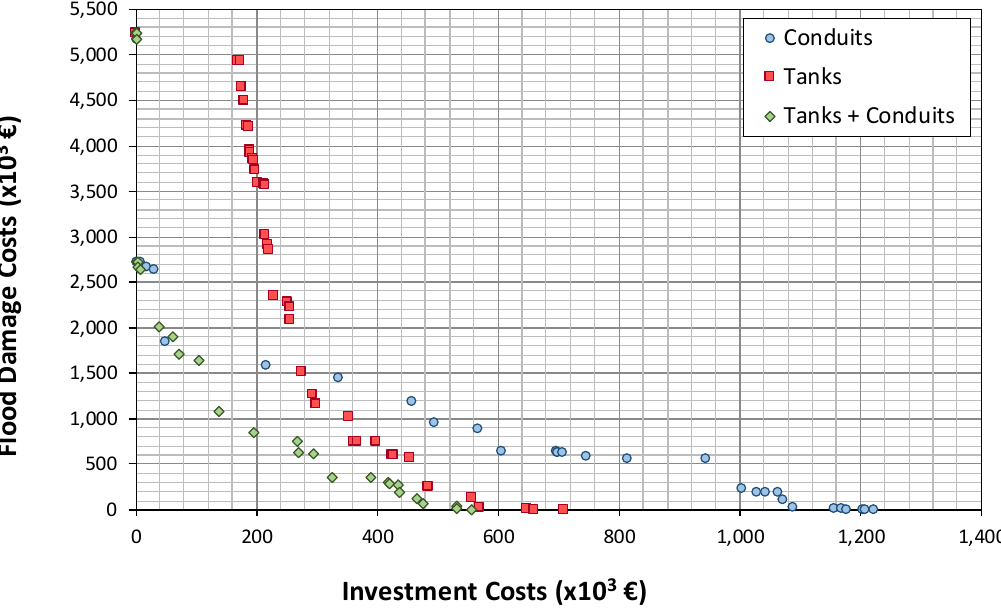
Figure 5. Pareto front representation of 3 different scenarios.